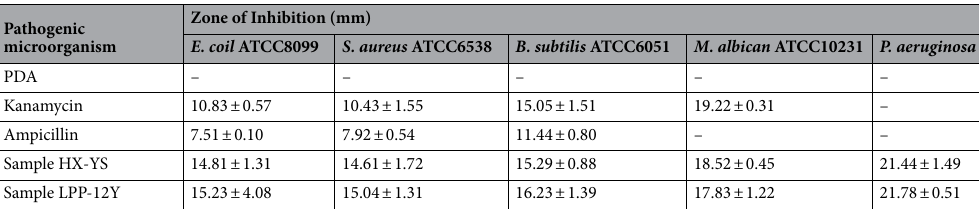
Table 2. Antimicrobial activity of AgNPs synthesized by HX-YS and LPP-12Y against five pathogenic microorganisms. * The zone of inhibition (ZOI) is recorded as the mean ± SD (n = 3). The diameter of the disks is 6 mm. “–” means no ZOI was